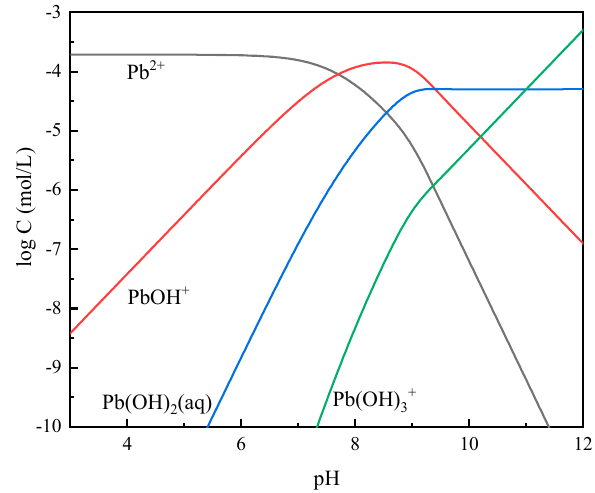
Figure 10. Species distribution diagram of 0.91 × 10 –4 mol/L Pb(II).